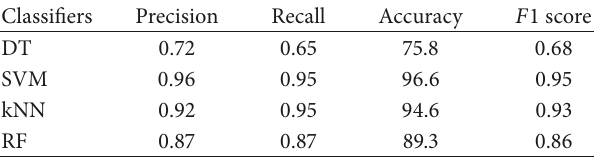
Table 4: Cooling system VMMS.